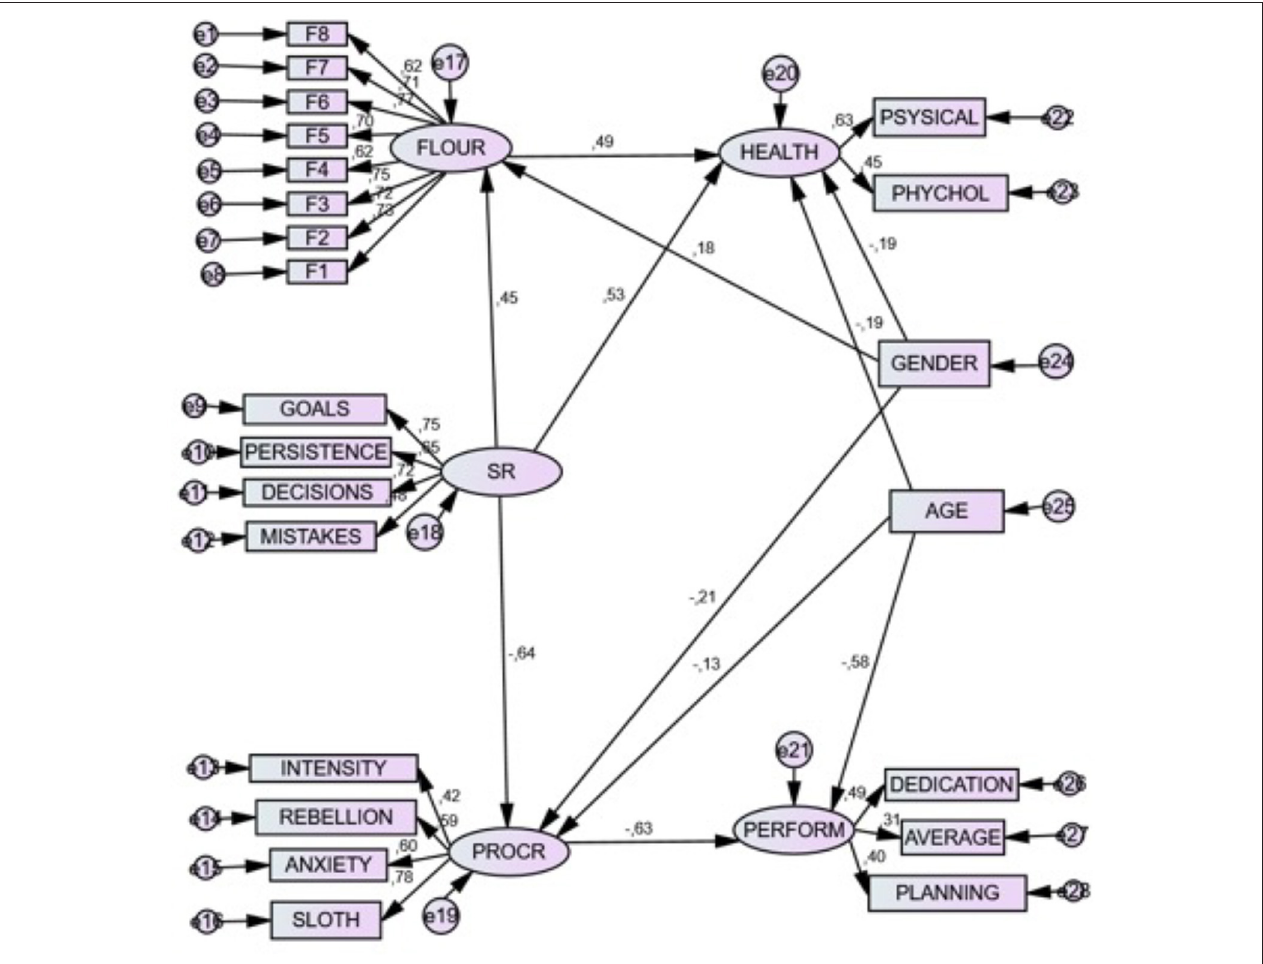
FIGURE 1 | Structural relations between the studied variables: SR, Self-Regulation; FLOUR, Flourishing; HEALTH, Health; PROCR, Procrastination; PERFORM, Academic Performance. All the coefficients were significant at p < 0.01.